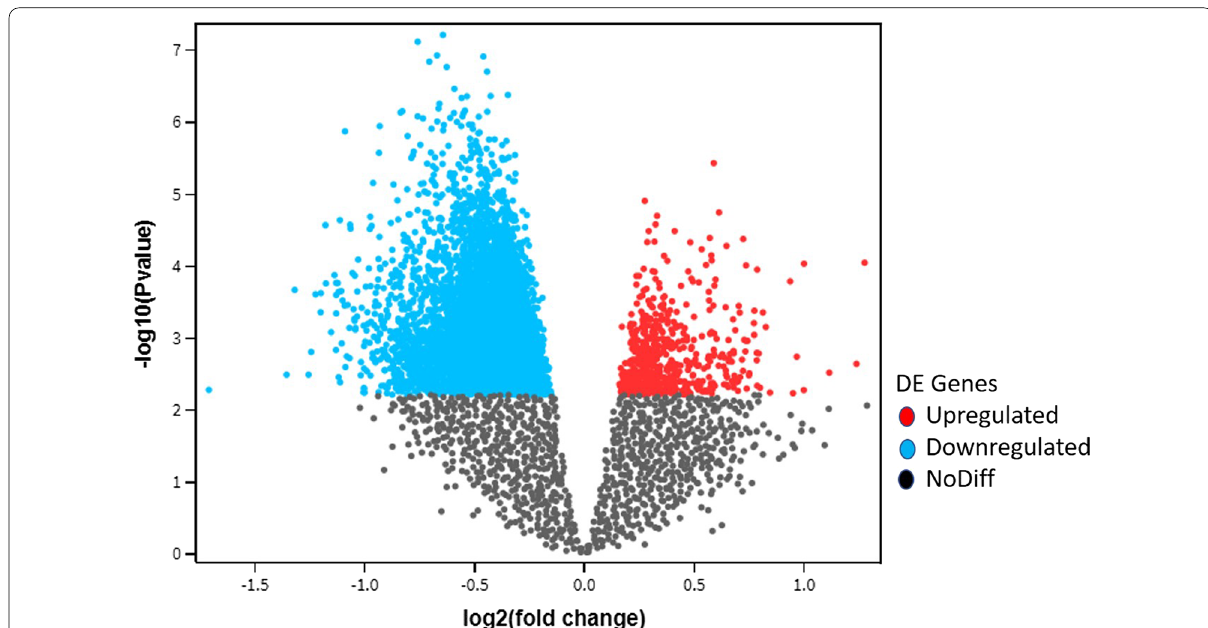
Fig. 1 Volcano map of all DEGs, screening criteria: P < 0 .05 and |logFC| respectively. FC fold-change, DEGs differentially expressed